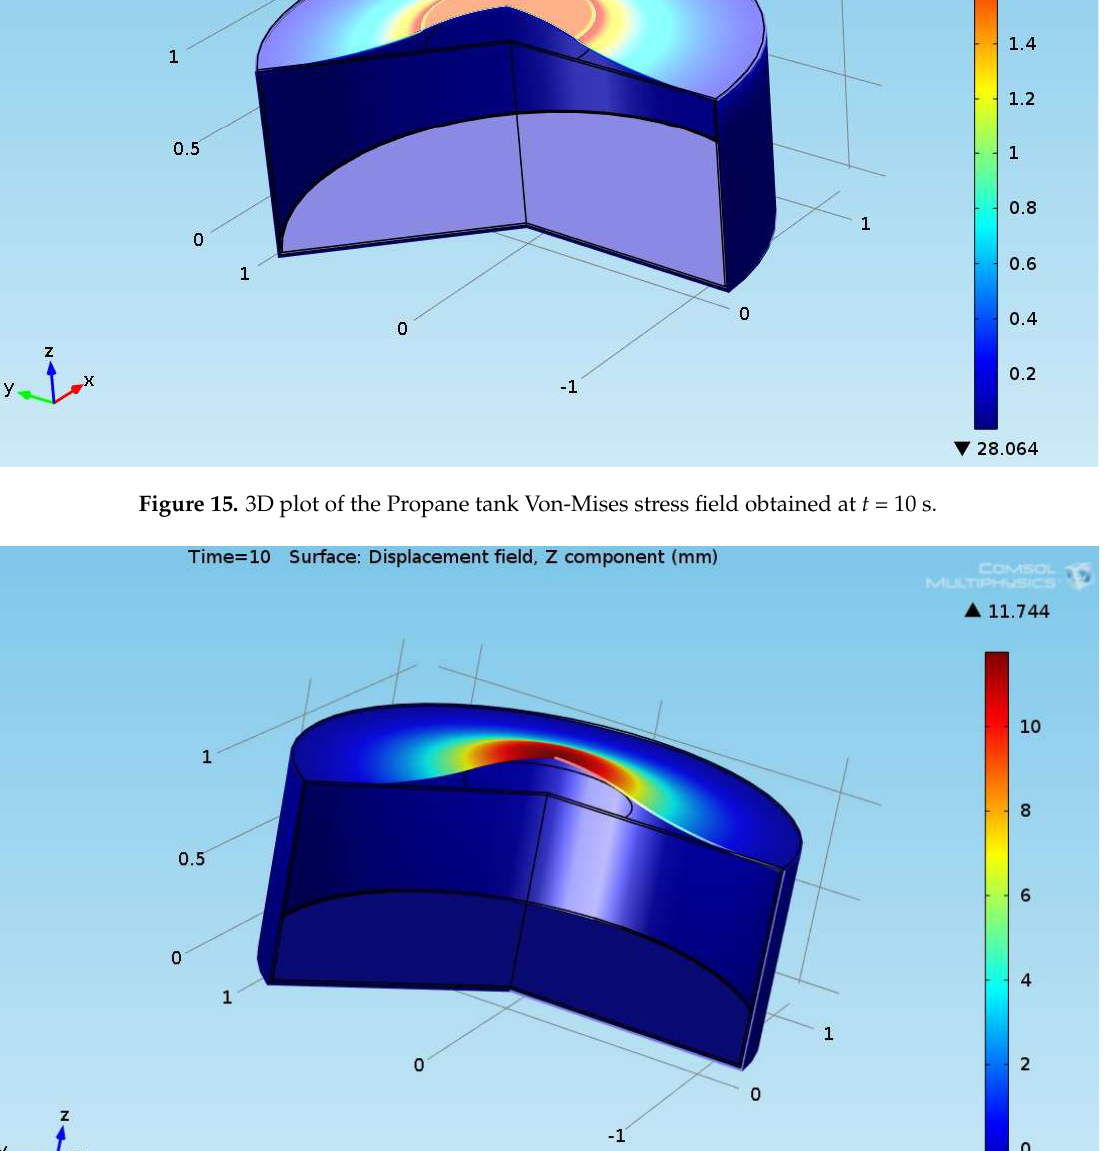
Figure 16. 3D plot of the Propane tank displacement field obtained at t = 10 s.